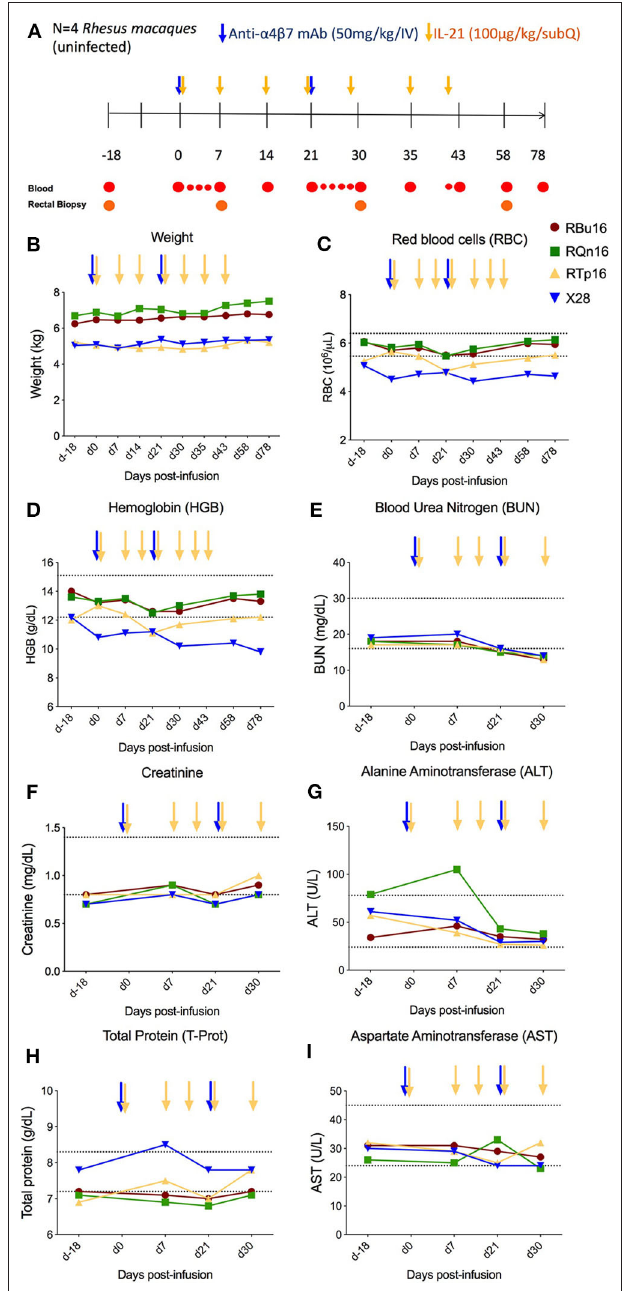
FIGURE 1 | Co-administration of anti- α 4 β 7 mAb and IL-21. (A) Schematic study design of co-administration of anti- α 4 β 7 mAb and IL-21 in uninfected RMs ( n = 4). Prior to treatment, baseline blood and RBs were collected. On day 0, 50 mg/kg of anti- α 4 β 7 mAb was administered intravenously along with 100 µ g/kg of IL-21 subcutaneously. IL-21 was given weekly up to 6 weeks (day 42 post-infusion). 50 mg/kg of anti- α 4 β 7 mAb was infused in two doses on day 0, week 3 (day 21 post-infusion). Blood samples were collected at regular intervals as shown in the schema. (B) Weight changes were recorded regularly until the end of treatment. (C) Red blood cells, (D) hemoglobin, (E) BUN, (F) creatinine, (G) ALT, (H) total protein, and (I) AST were analyzed from the blood collected at regular intervals until the end of the study. Individual (Continued)